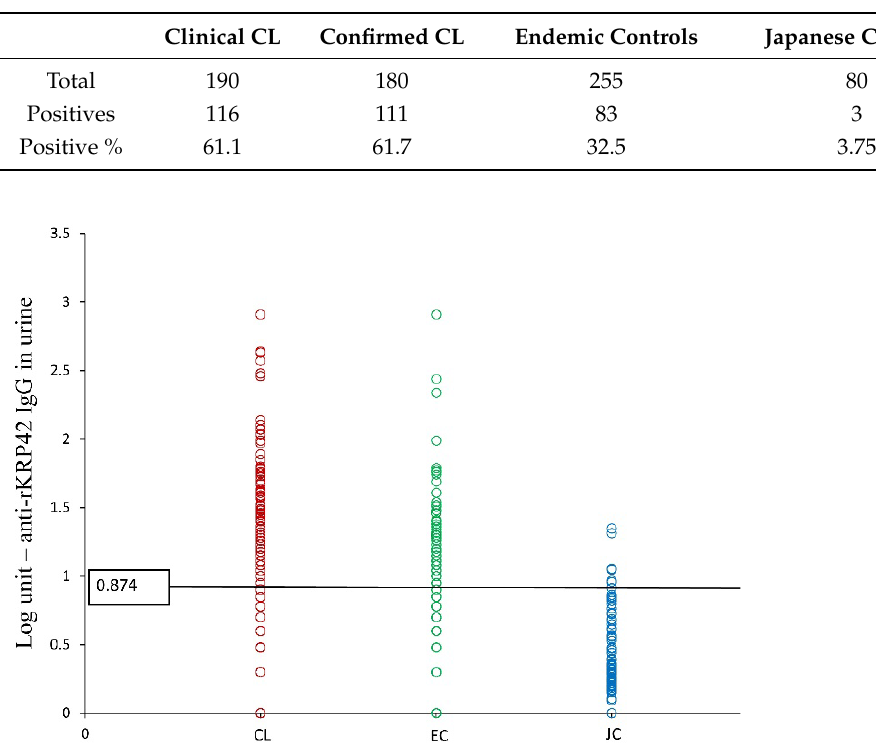
Figure 4. Anti-rKRP42 IgG titers in urine, comparison among groups.